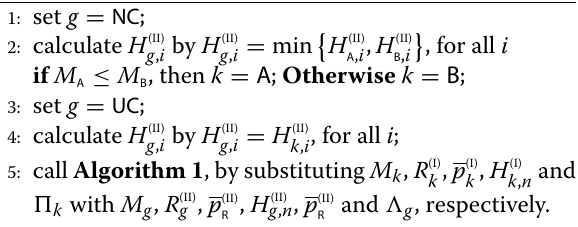
Algorithm 2 Subcarrier assignment algorithm for relay